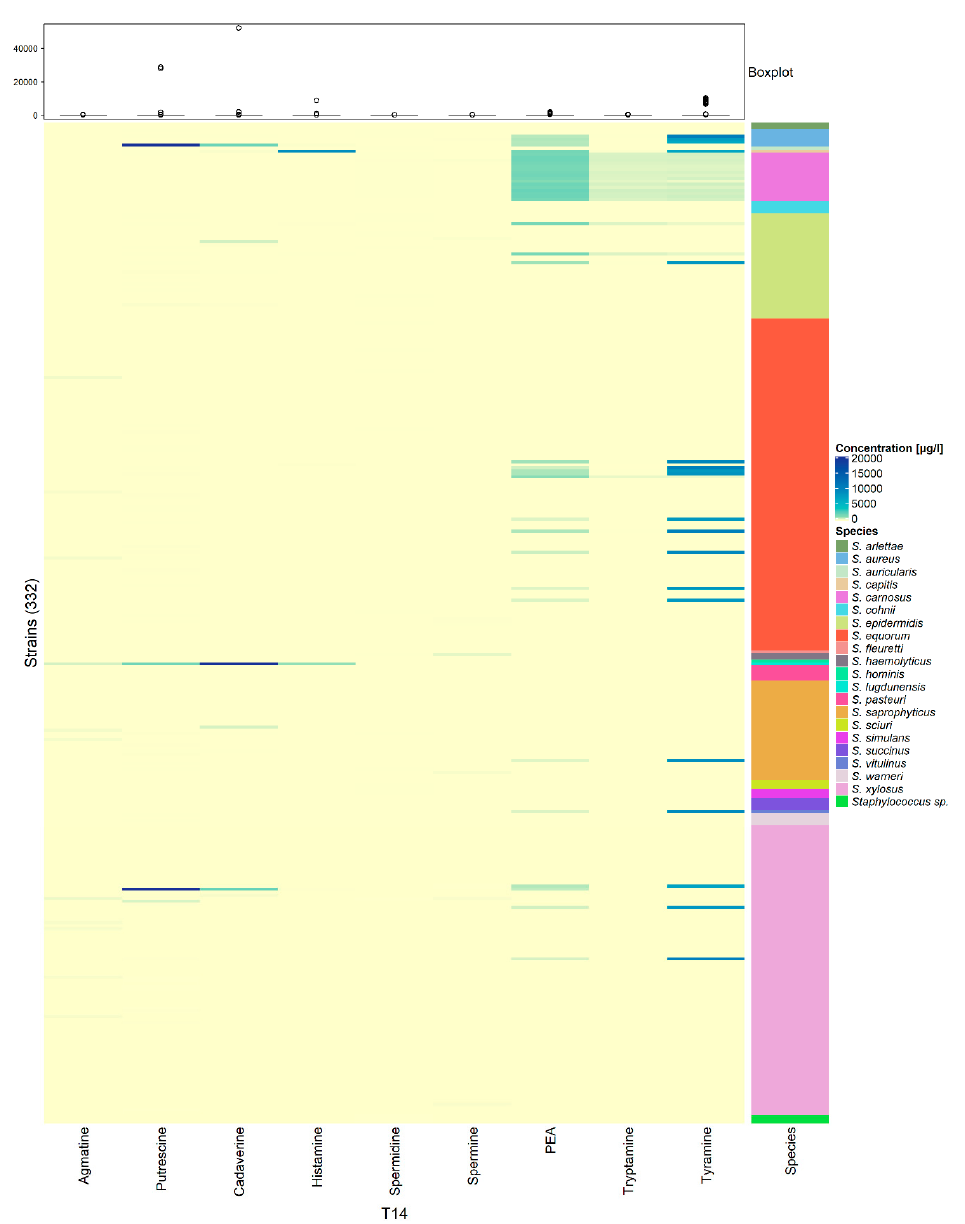
Figure 2. Heatmap showing the increase in different biogenic amine concentrations (µg/L) after 14 d of incubation in BHI broth, for all 332 staphylococcal strains (ordered alphabetically according to species name). A concentration range from 0 to 20,000 µg/L was chosen to display most of the measured samples, while the indicative boxplot shows the complete concentration range per biogenic amine for all strains.